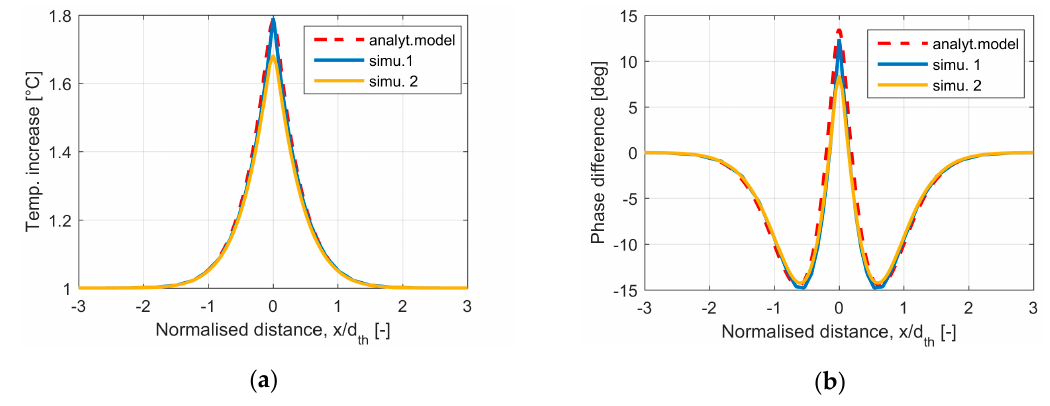
Figure 3. Temperature ( a ) and phase difference ( b ) around a crack calculated with the three models for the same case as in Figure 1 and in Figure 2.